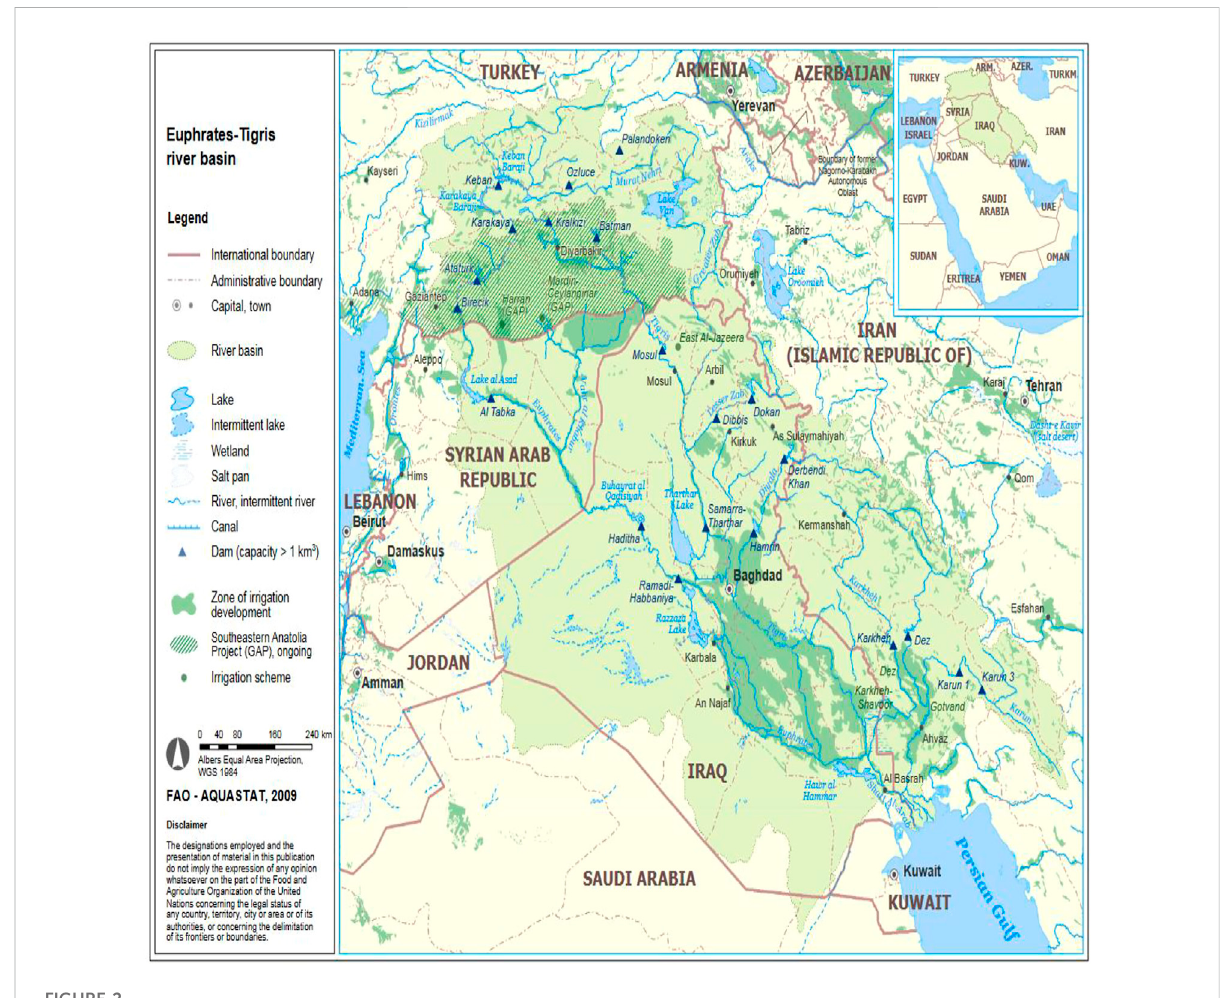
FIGURE 2 Tigris-euphrates river basin (TWAP,